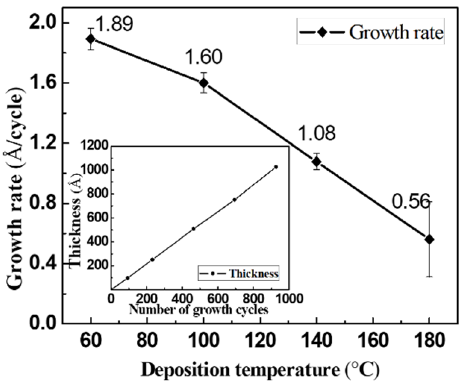
Figure 1. Growth rates of the Sn x S y films at deposition temperatures in the range of 60 to 180 °C. The thickness of the Sn x S y film linearly increased with the number of growth cycles at 140 °C (inset).